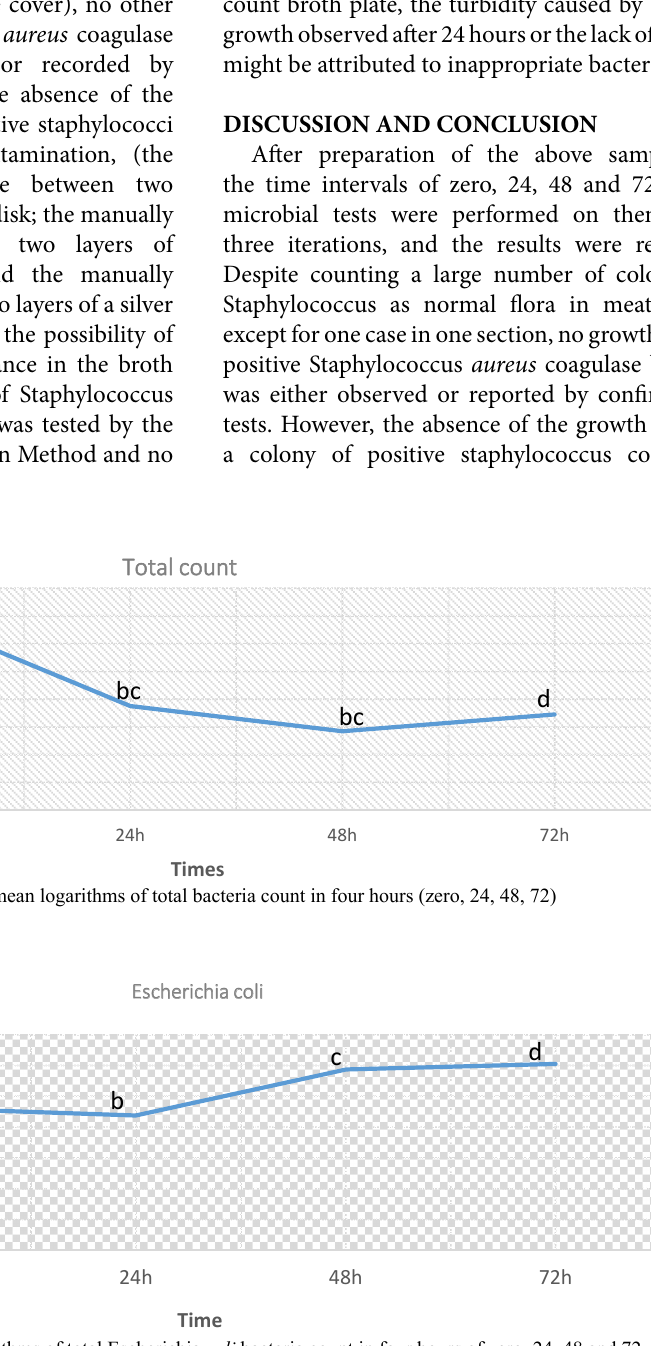
Figure 2. Comparing mean logarithms of total Escherichia coli bacteria count in four hours of zero, 24, 48 and 72